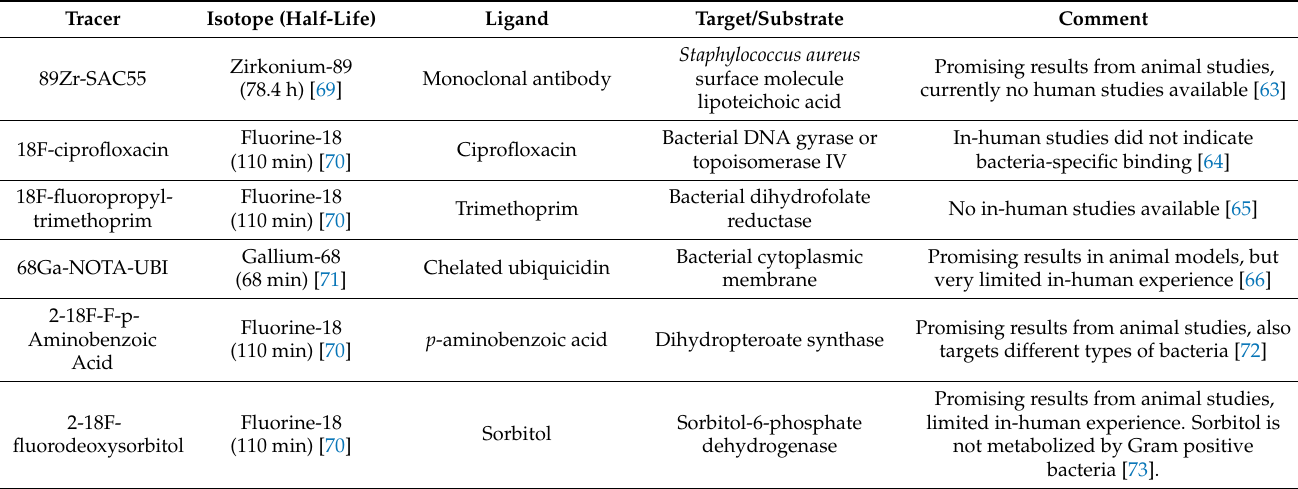
Table 1. Various examples of bacterial (novel)tracers for